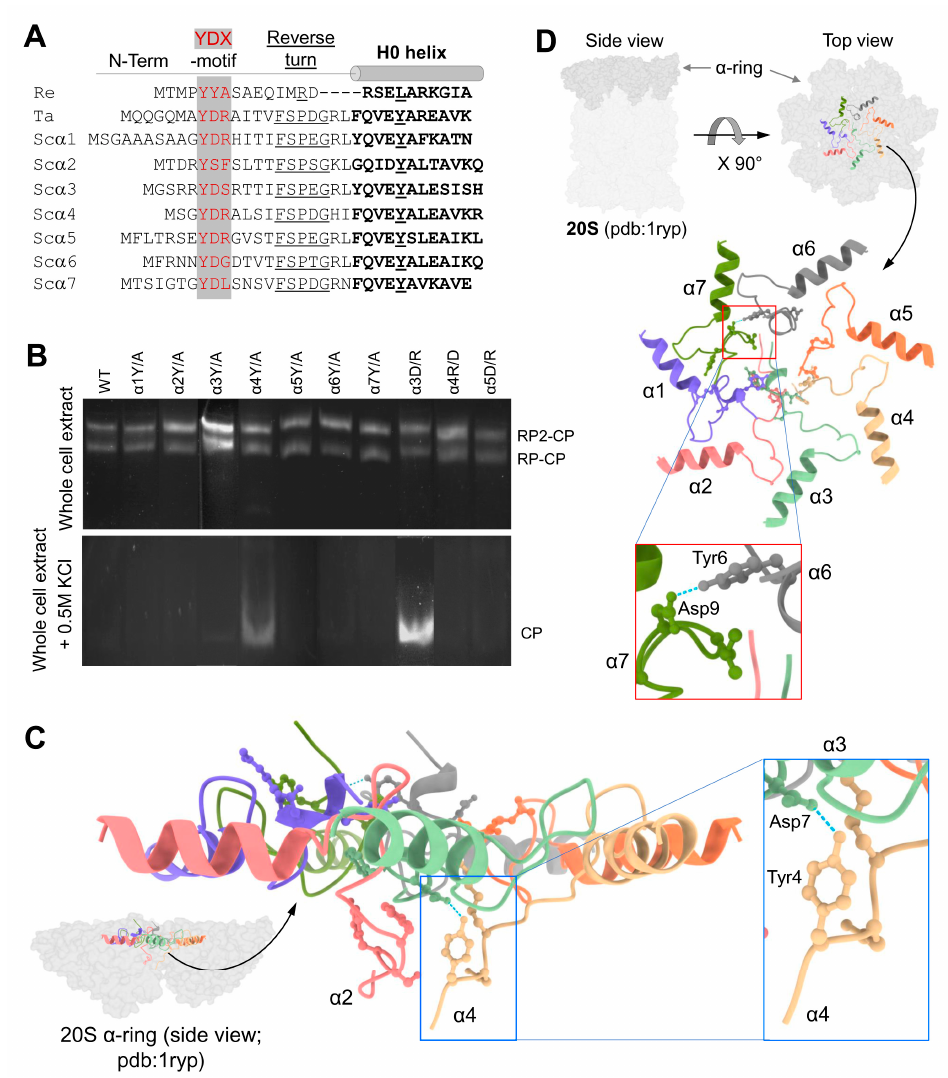
Figure 1. YDX motif of α -subunits is important for 20S closed-gate stability. ( A ) Sequence alignment of the N-terminal regions of 7 α -subunits of Saccharomyces cerevisiae (Sc) proteasome and the single α -subunits of Thermoplasma acidophilum (Ta) and Rhodococcus erythropolis (Re) proteasomes. The conserved YDX motif, Reverse Turn and H0 helix are marked. ( B ) Yeast mutant strains expressing 10 single point mutations within the YD(X) motif of respective α subunits were natively lysed, and peptidase activity of the 26S holoenzyme was monitored by non-denaturing gel electrophoresis (top panel). In each strain, tyrosine 8 of one α -subunit was substituted by alanine. Additionally, in some of the α subunits, also Aspartate 9 or Arginine 10 was substituted. Adding 0.5 M KCl and incubation of the cell extracts at 30 °C for 30 min resulted in 26S disassembly, and peptidase activity of the stable 20S CP was visualized (bottom panel). ( C ) Side view of α -ring (pdb:1ryp) highlights the lower plane of the α 2 and α 4 N-termini conformations in the closed state. The blue dash lines represent the H-bond between the α 4Y and α 3D residues of their YD(X) motifs. ( D ) A cartoon representation of resting 20S (pdb:1ryp) α -ring with surface view shows the N-terminal regions up to the H0-helix. Inserts show a zoom-in of the hydrogen bonds between the α 6Y–D α 7 pair.